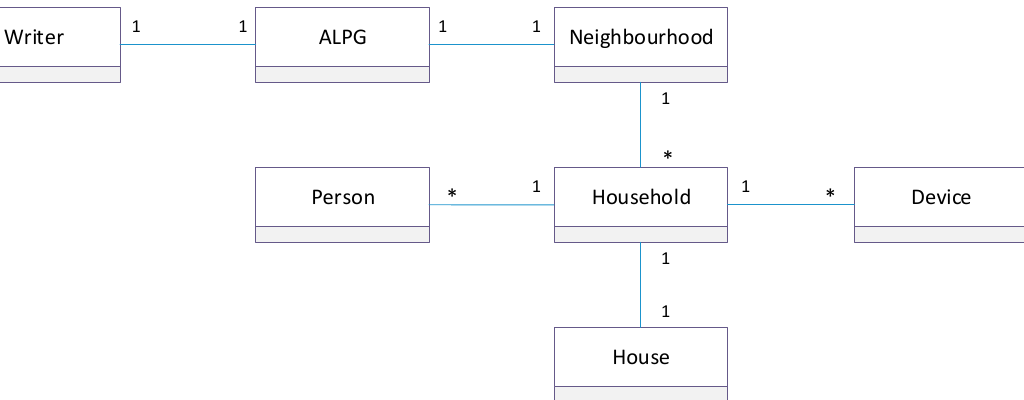
Figure 5. ALPG’s class diagram [17] that shows the cardinality of a class in relation to another.